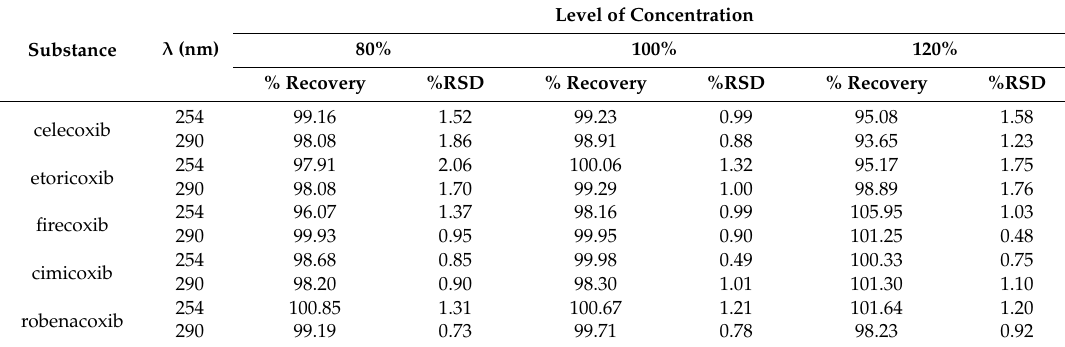
Table 4. Results of the